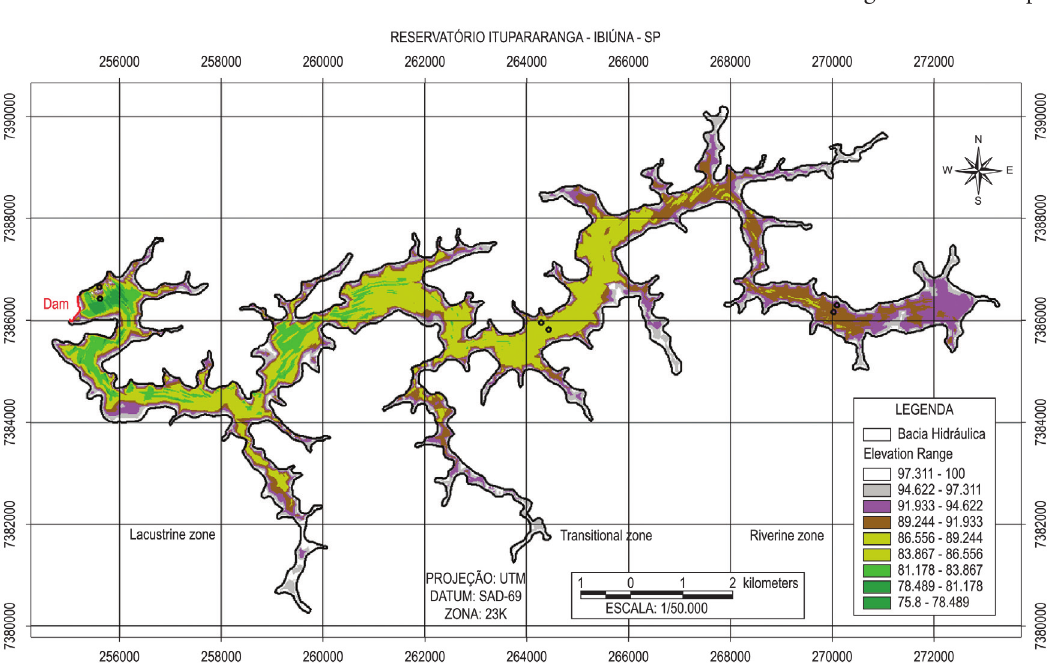
Figure 2. The Itupararanga Reservoir, SP, Brazil. Figure showing the reservoir batimetry; the riverine, transitional and lacustrine zones designed a priori , based on Thornton et al., 1982; the dam’s position (detached in the map) and the circles are the sample points.